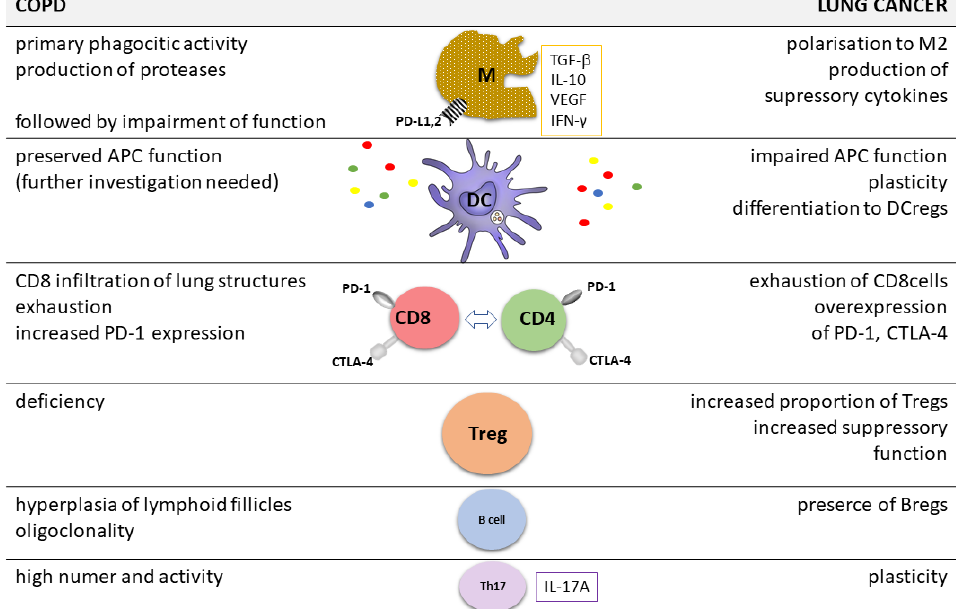
Figure 1. Main lymphoid cells involved in immune reaction in COPD and lung cancer. APC—antigen presenting cell, Bregreg—regulatory B cell, COPD—chronic obstructive pulmonary disease, CTLA-4—cytotoxic T cellll antigen-4, DC—dendritic cell, DC-reg—regulatory DC cell, IL—interleukin, IFN- γ — interferon γ , M—macrophage, PD-1—programmed death-1, TGF- β —transforming growth factor β . Treg-regulatory T cell, VEGF-vascular endothelial growth